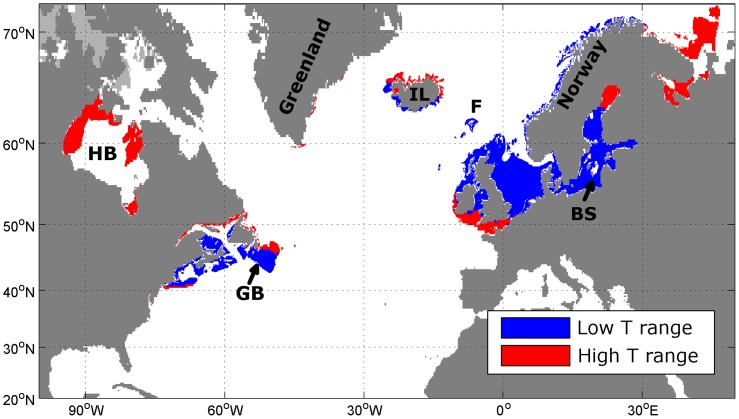
Today's grey seal range.Predicted grey seal habitat today based solely on water depth and annual climatological sea surface temperature data. For this estimate, grey seals inhabit a depth range between 0 m and 127.5 m and a SST range of 5.4°C to 11.7°C (blue) or 2.7°C to 12.6°C (blue and red). Isobath is 500 m, land is shaded dark grey and summer ice cover is light grey. Some important topographic features are marked: Hudson Bay (HB), Grand Banks (GB), Iceland (IL), the Baltic Sea (BS) and the Faroe Islands (F).